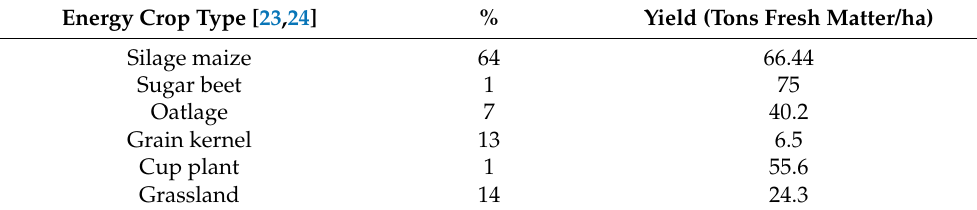
Figure 1. BioPot methodology. Table 3. Applied allocation factors for biomass